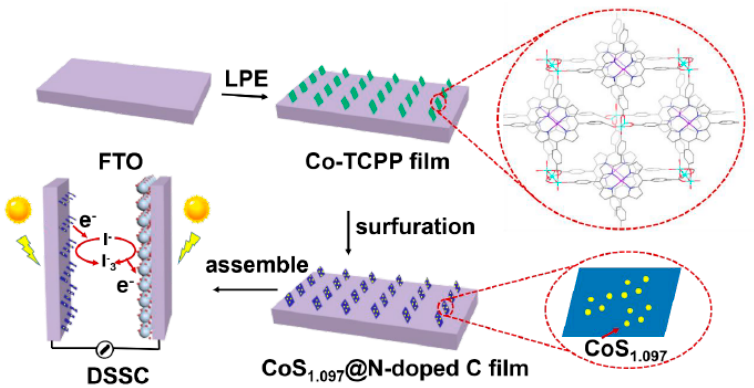
Figure 9. Schematic illustration of preparation process of CoS1.097@N-doped carbon film CE for DSSCs. Reproduced with permission from [167] .